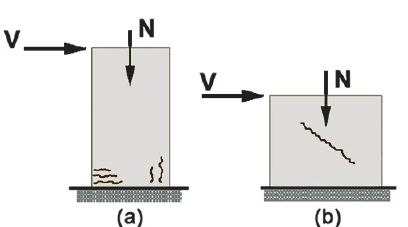
Figure 9: In-plane failure modes of masonry piers subjected to eccentric axial force: (a) flexural, (b) shear diagonal cracking.  are related to the spandrel resistance of the i-th floor masonry walls: their values are 1.0  and The coefficients yi xi